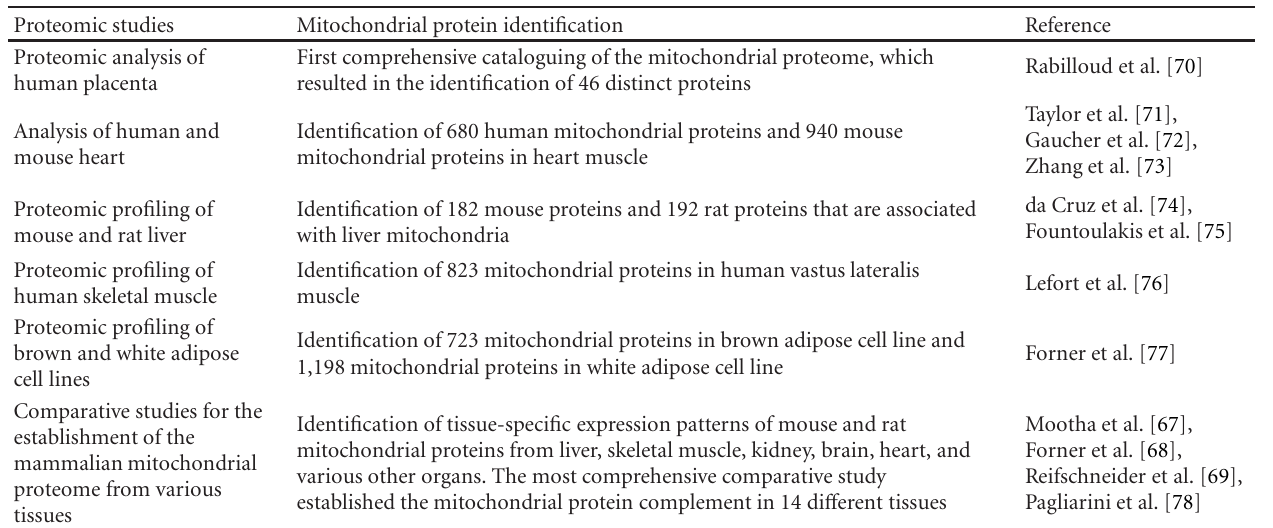
Table 1: List of major profiling studies of the mitochondrial